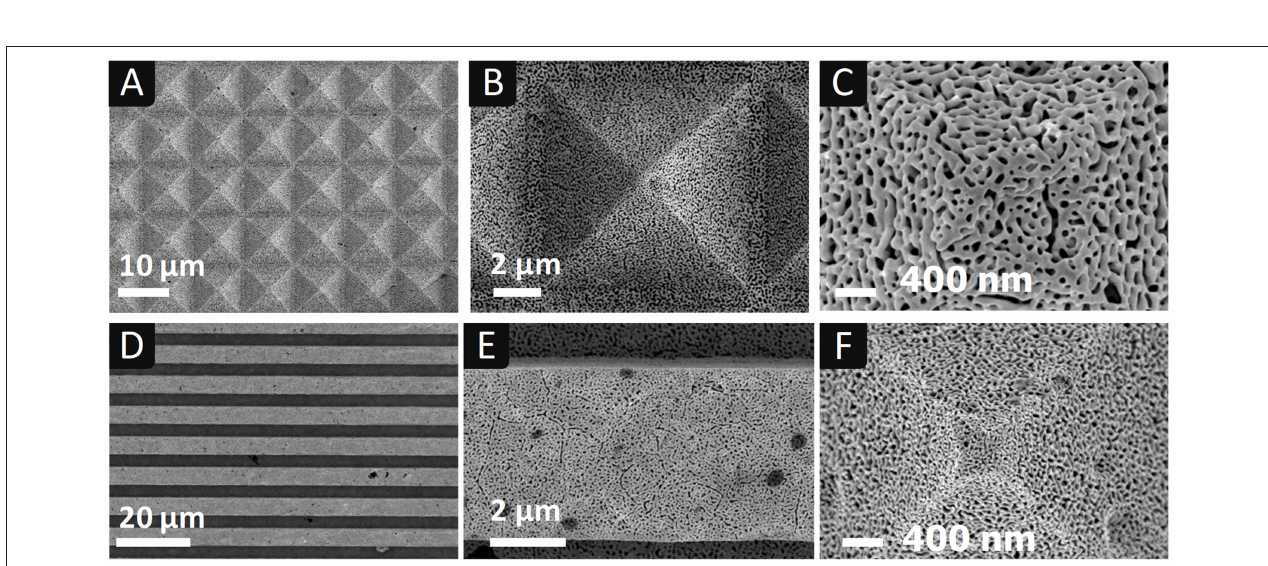
FIGURE 2 | SEM images of np-Au electrodes elaborated by: (A) electrochemical dealloying at 0.7 V SME in HClO 4 (0.77mol L − 1 ) at 60 ◦ C for 53h; (B) chemical dealloying in HNO